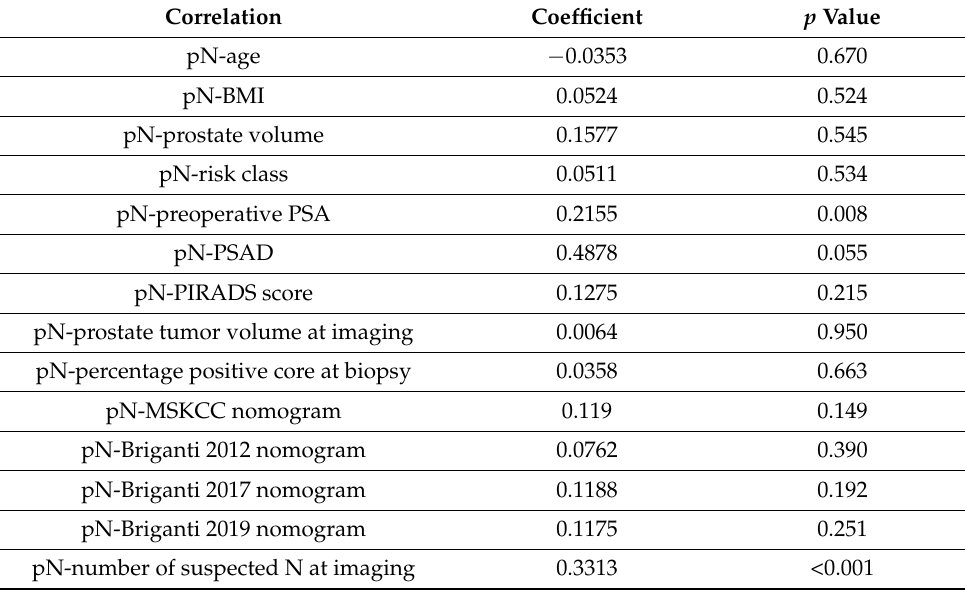
Table 3. Pearson correlation coefficient among pathological N stage (pN) and the other clinical and pathological